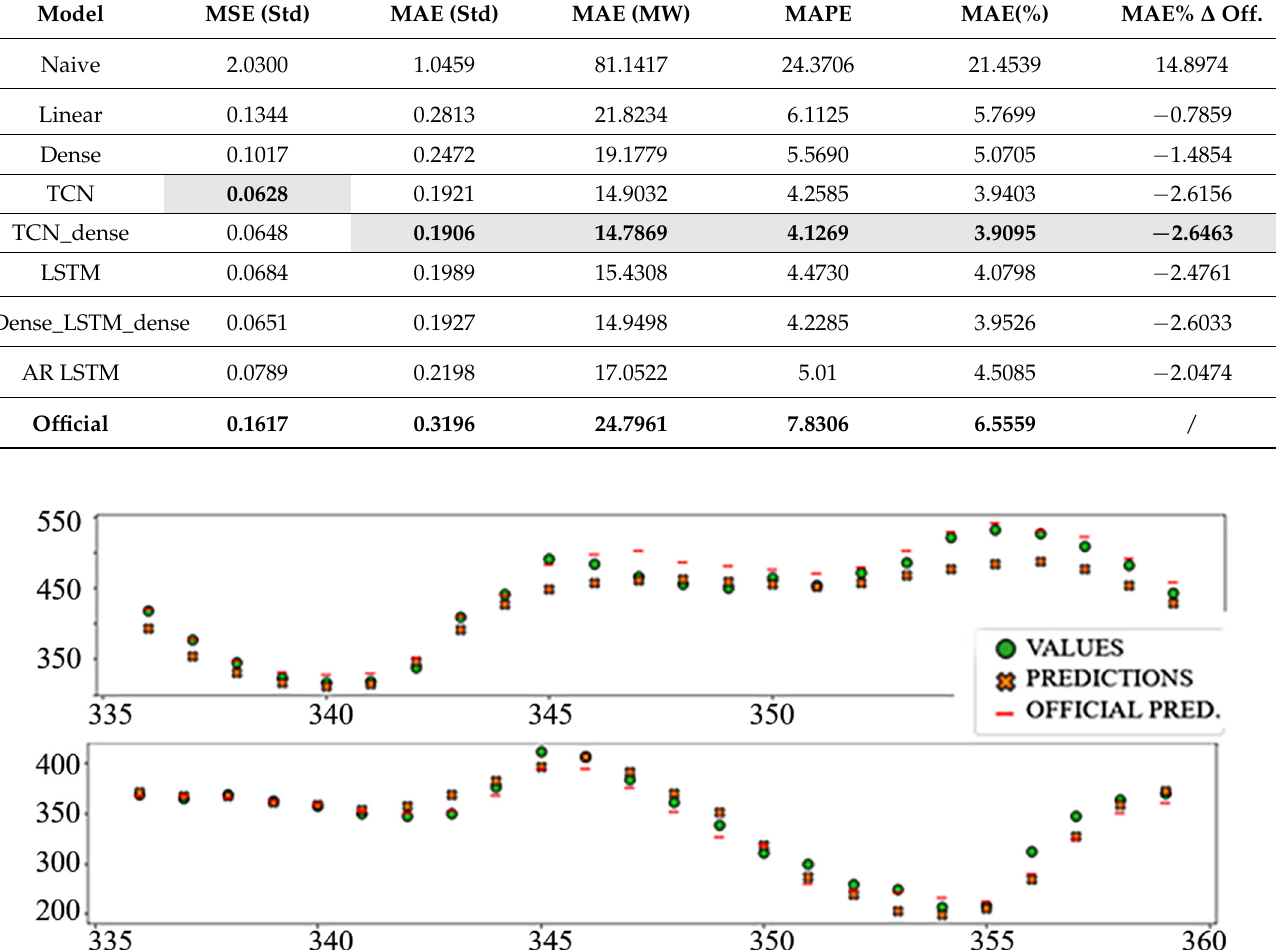
Table 4. Performance of models for electricity load prediction in comparison to the official prediction.